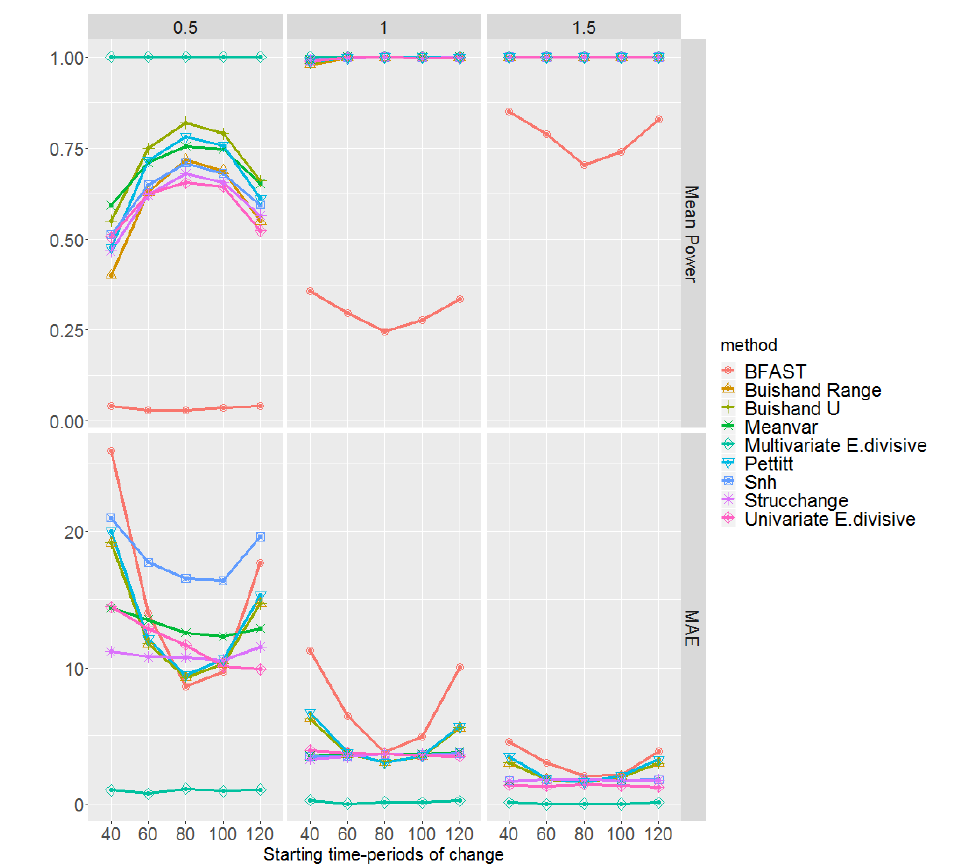
Figure 5. Mean empirical power of the tests and mean absolute error (MAE) of the change-point detection methods with respect to the magnitudes of change 0.5,1,1.5 and starting time-periods of change 40,60, . . . ,120. These are based on 100 simulations of multi-layer rasters under the first scenario, where pixel time series are generated from the standard normal